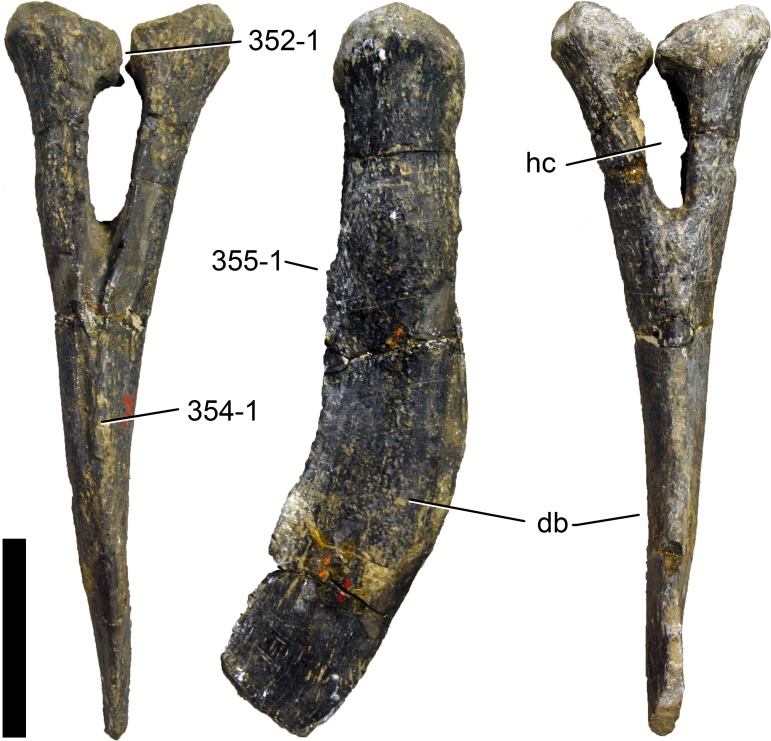
Anterior chevron of Apatosaurus ajax YPM 1860 in anterior, right lateral, and posterior view (left to right).Note the crus bridging the haemal canal dorsally (broken here; C352-0), the anterior, longitudinal median ridge (C354-1), and the step-like posterior expansion of the distal blade (C355-1). Abb.: db, distal blade; hc, haemal canal. Scale bar = 10 cm.